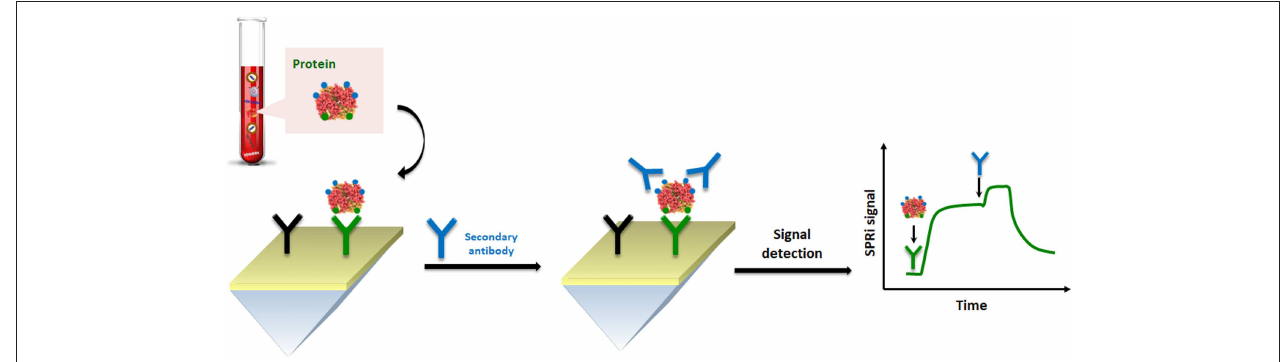
FIGURE 5 | Pictorial description of SPRi sensing of HER-specific exosome (protein) in breast cancer cell lysates.